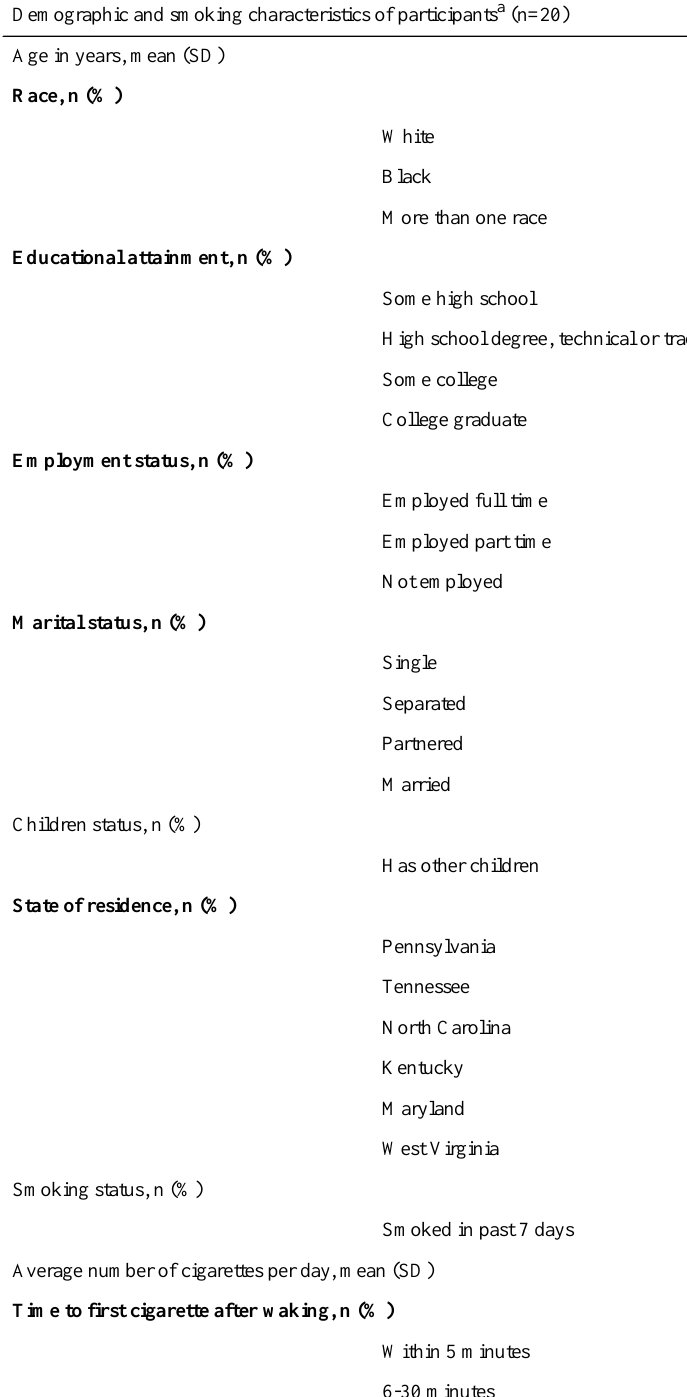
Table 1. Participant demographics and smoking